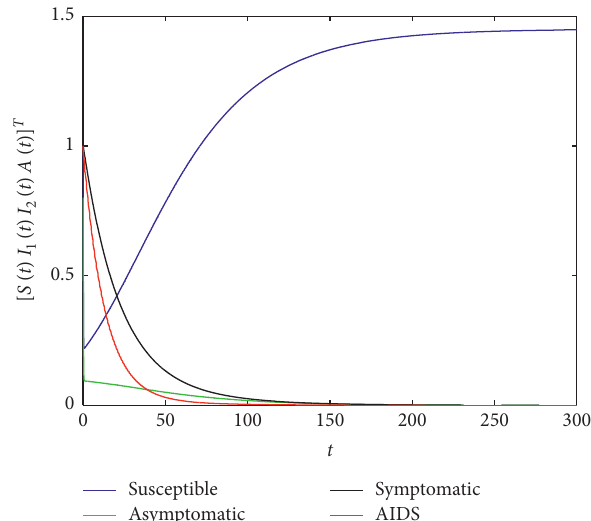
Figure 1: The solutions of system (1) with the fractional order α � 0 .